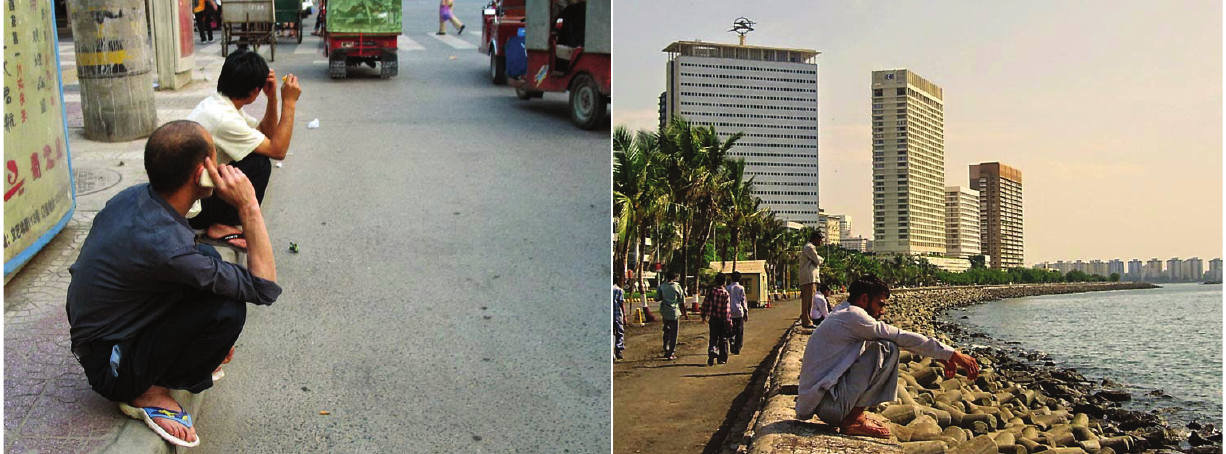
Figure 10. People sitting on one’s haunches as common practice. Source: Stock Pictures